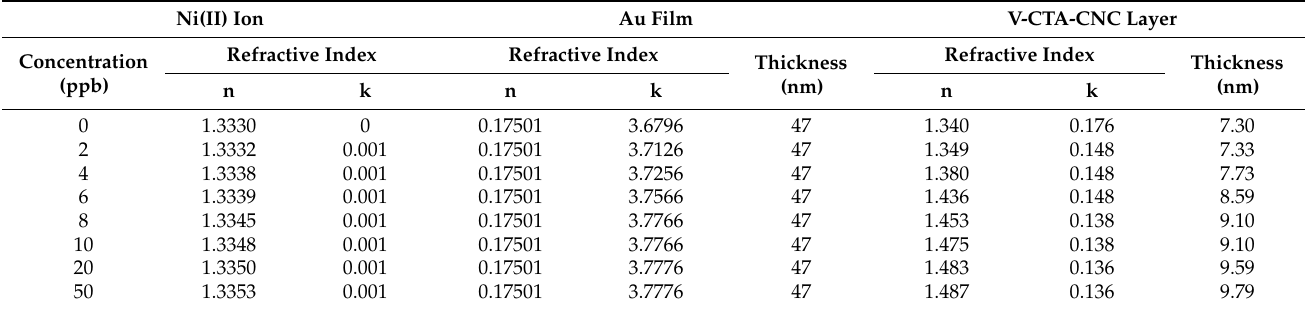
Table 2. The real part of the refractive index, the imaginary part of the refractive index, and the thickness of the proposed sensor film when exposed to Ni(II) ion solution ranged from 2 ppb to 50